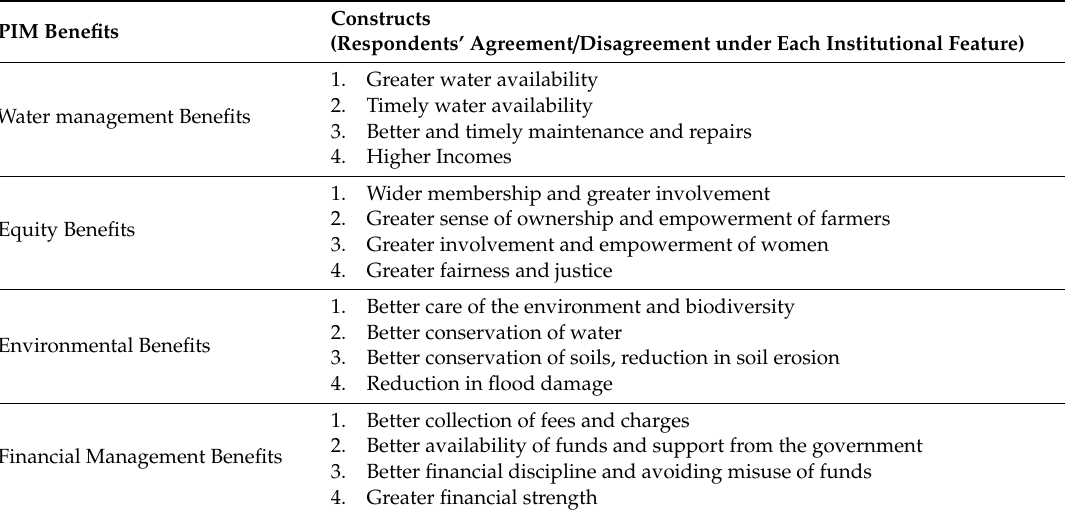
Table A2. Impact of participatory irrigation management institutions.